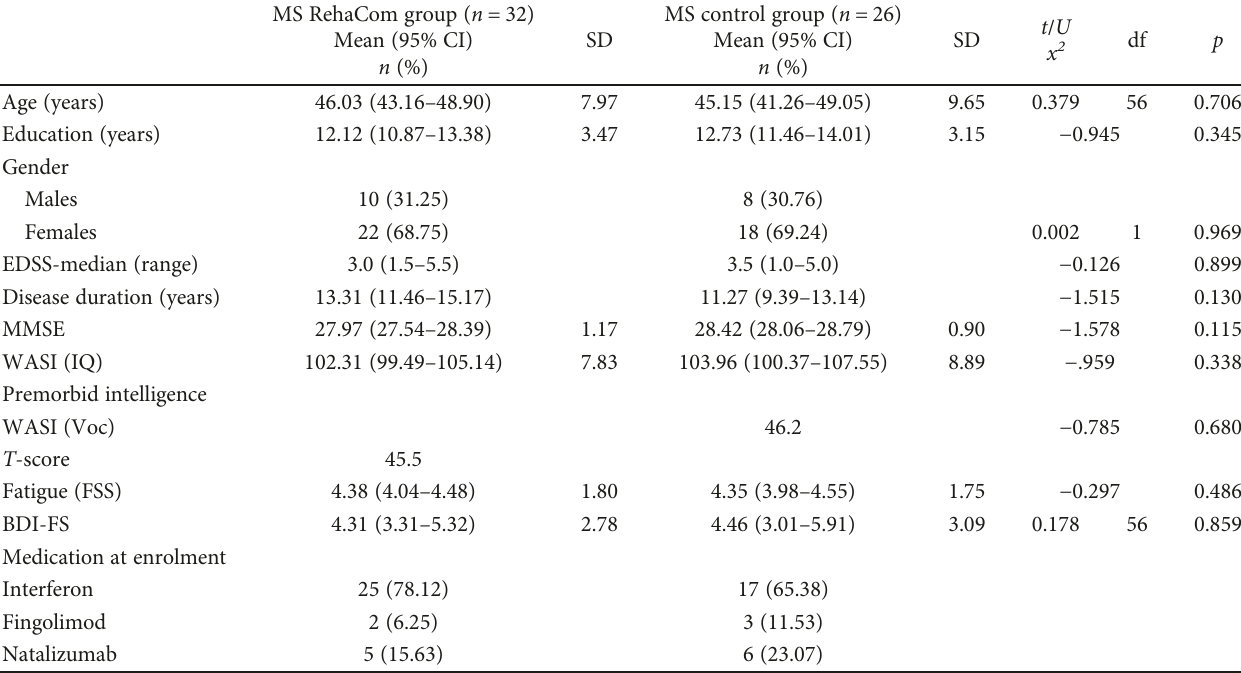
Table 1: Demographic and clinical characteristics of the sample at